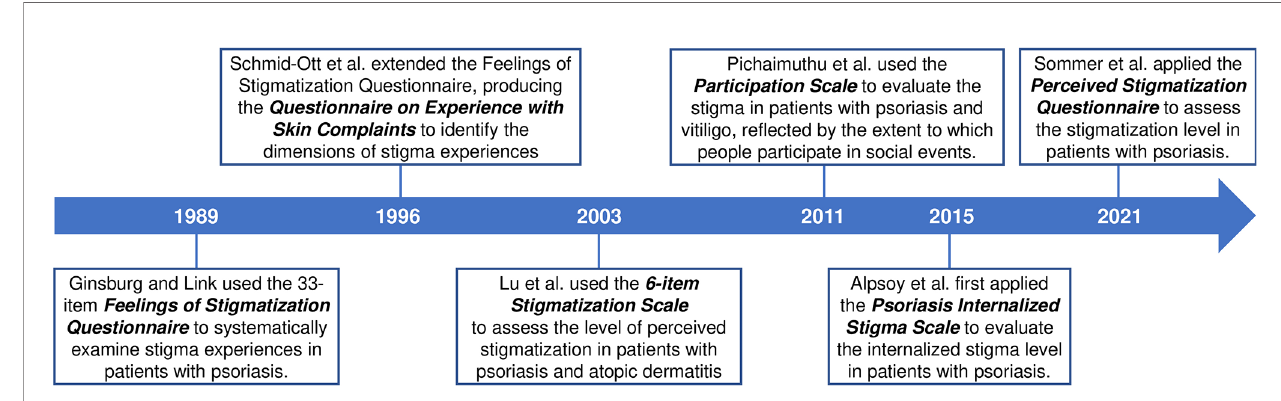
FIGURE 1 | Commonly used questionnaires and scales to evaluate the stigmatization in patients with